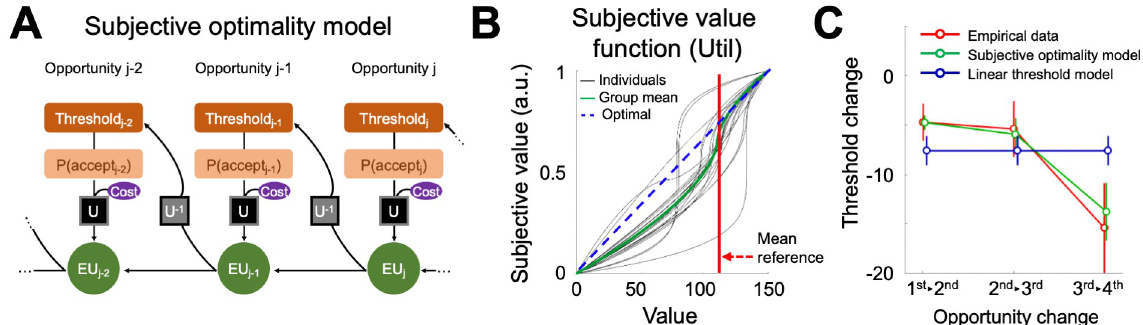
Fig 2. Subjective optimality model. (A) The optimal decision model assumes that individuals compute the decision threshold of a certain opportunity based on the expected value of successive opportunities. In the ‘Subjective optimality model’, expected values of the successive opportunities are replaced by expected utilities (EU) calculated based on the subjective value function as per Prospective theory. (B) Two free parameters, reference point, and nonlinear value sensitivity define subjective valuation of the presented stimuli values. Group average subjective value function (green) is depicted using the group mean of individual estimates: reference point = 110.51; value sensitivity = 0.62. (C) Decision thresholds calculated from empirical data showed a decreasing pattern along the opportunities, but moreover, the extent of threshold change between opportunities also showed a decreasing pattern (i.e., second derivative of the decision threshold curve < 0). Such a change in the slope of decision threshold curve is a unique feature that our suggested Subjective optimality model successfully could explain (differences between the model and empirical data do not vary across opportunities; F(2, 38) = 0.70, η 2 = 0.036, p = 0.090), and has superior explanatory power to the linear threshold model. Negative values on the y-axis indicate that decision thresholds decrease between opportunities. Error bars indicate